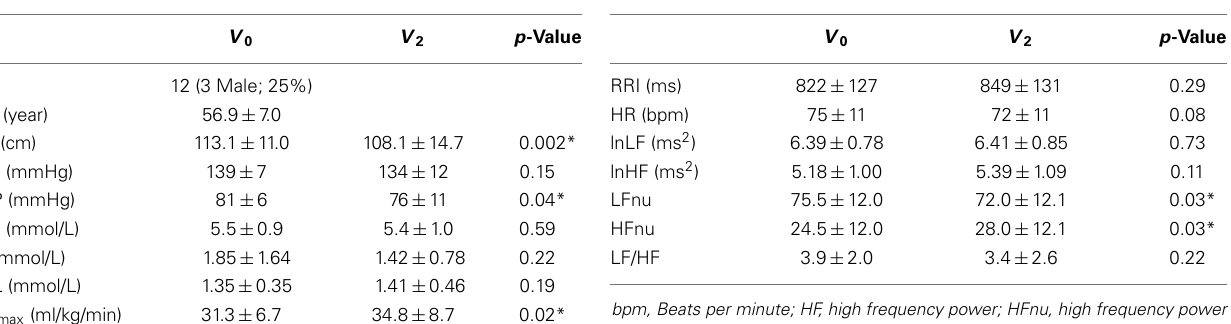
Table 1 | Participant characteristics and changes in metabolic Table 2 |Twenty-hour heart rate variability before and after the 8-week